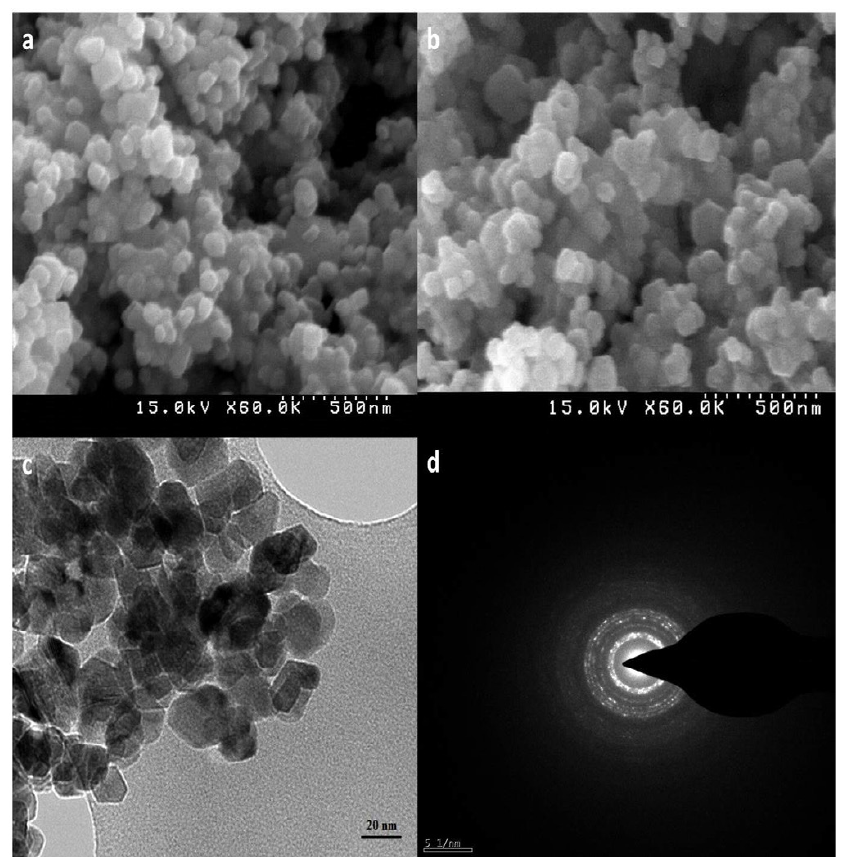
Fig. 4. SEM images of the (a) ZnS and (b) Zn Figure 4.SEM images of the (a) ZnS and (b) Zn 0.94 Yb 0.06 S and (c) TEM image of Zn 0.94 Yb 0.06 S